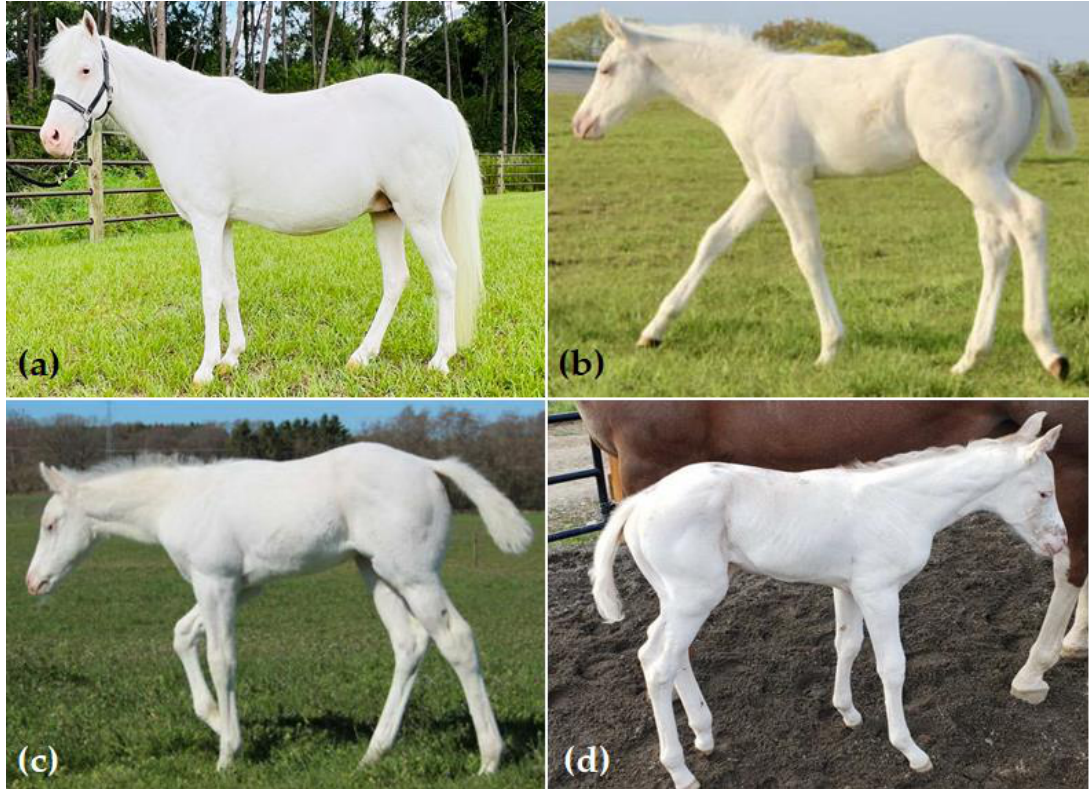
Figure 1. Four horses homozygous for the SB1 white patterning allele ( SB1 / SB1 ). ( a ) Shetland Pony with chestnut base coat and silver dilution ( e/e a/a Z/N ) with no other tested dilution or white patterning alleles detected; ( b ) Paint Horse with chestnut base coat ( e/e A/A ); ( c ) Paint Horse with bay base coat ( E/e A/A ); ( d ) Paint Horse with bay base coat ( E/e A/A ); ( b – d ) No other tested dilution or white patterning alleles were detected in these horses.